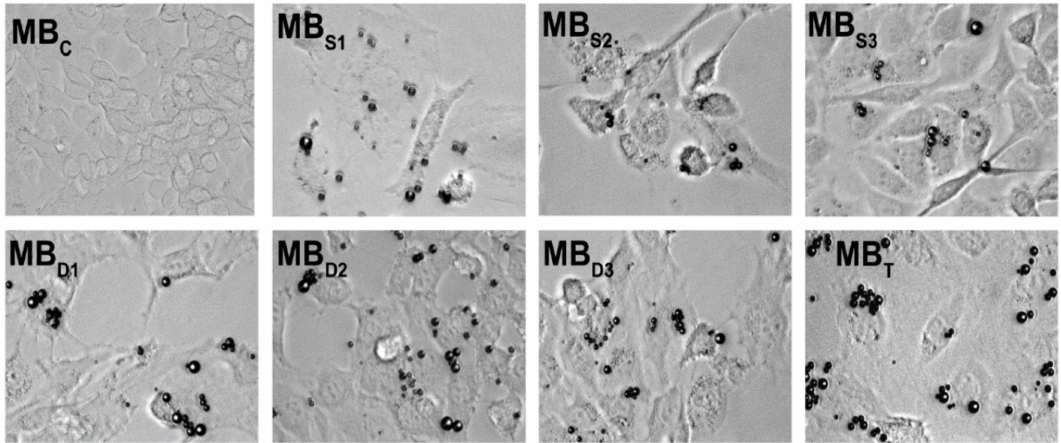
Figure 8. In vitro microscopy images of control (MB C ), single (MB S ), double (MB D ), and triple (MB T ) targeted MB adhered on cells. Triple targeted MB adhere more on the cells than single or double targeted ones. Reproduced with permission from [139]. Copyright John Wiley and Sons,